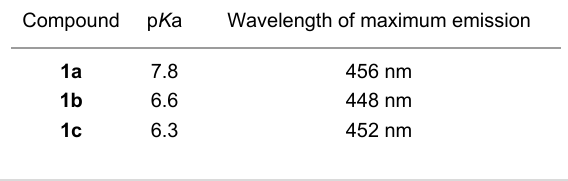
Table 3: p K a values of compounds 1a , 1b and 1c and their corres- ponding wavelengths of maximum emission. Compound